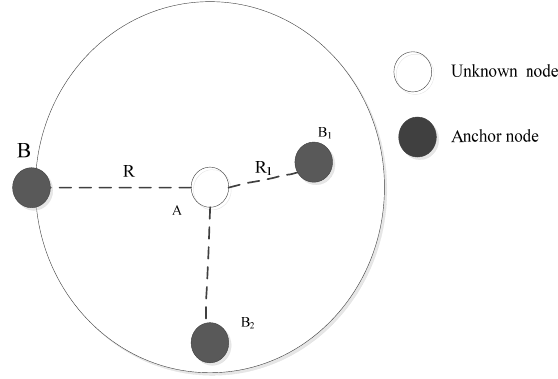
Figure 2. Hop quantization between nodes.